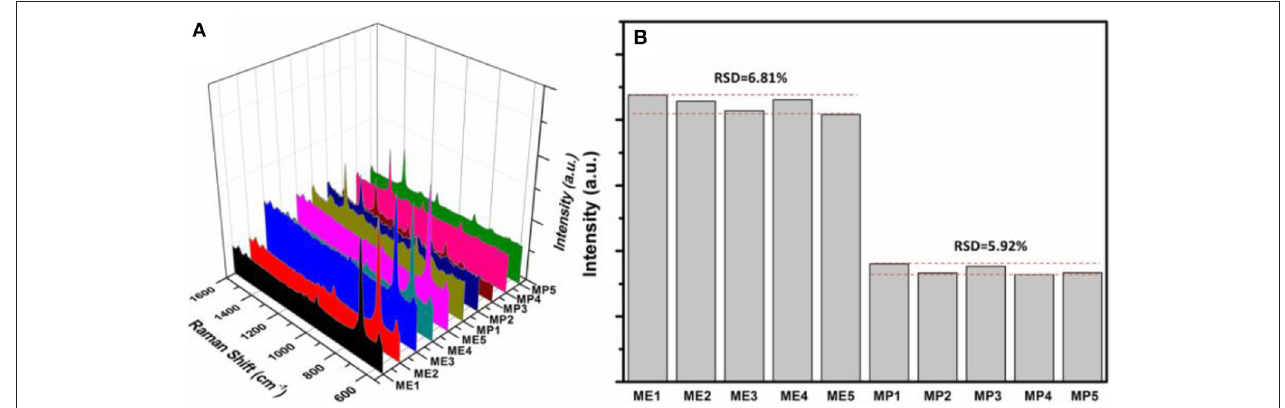
FIGURE 7 | (A) Raman scattering spectra of 5 wax/AuNPs-melamine/AuNPs samples and 5 wax/AuNPs-methyl parathion/AuNPs samples prepared at melamine and methyl parathion concentrations of 1 × 10 − 6 M. (B) Plot of the absolute Raman intensities at 687.4 cm − 1 for melamine and 1346.6 cm − 1 for methyl parathion from five different samples, respectively.